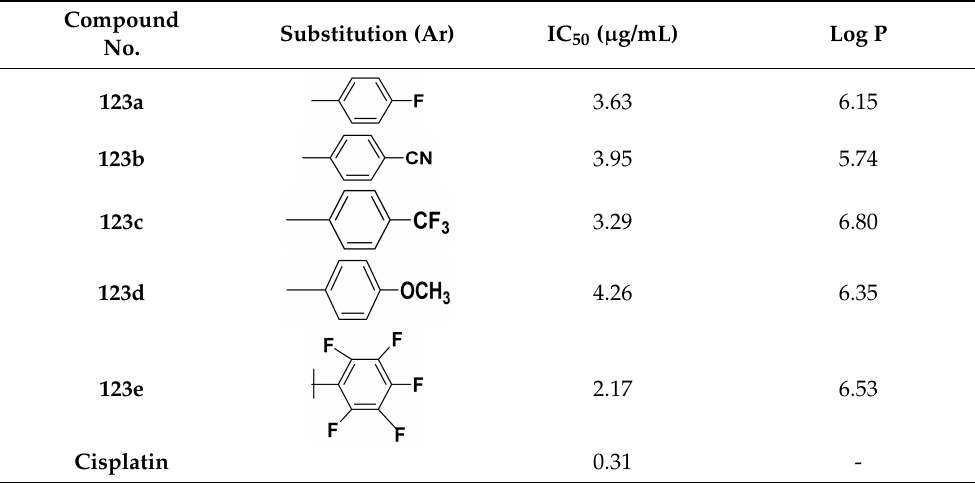
Figure 117. Structure of nitrogen mustard-containing thiazole derivatives 123 ( a – e ). Table 104. In vitro cytotoxic activities of nitrogen mustard-containing thiazole hybrid compounds 123 ( a – e ).